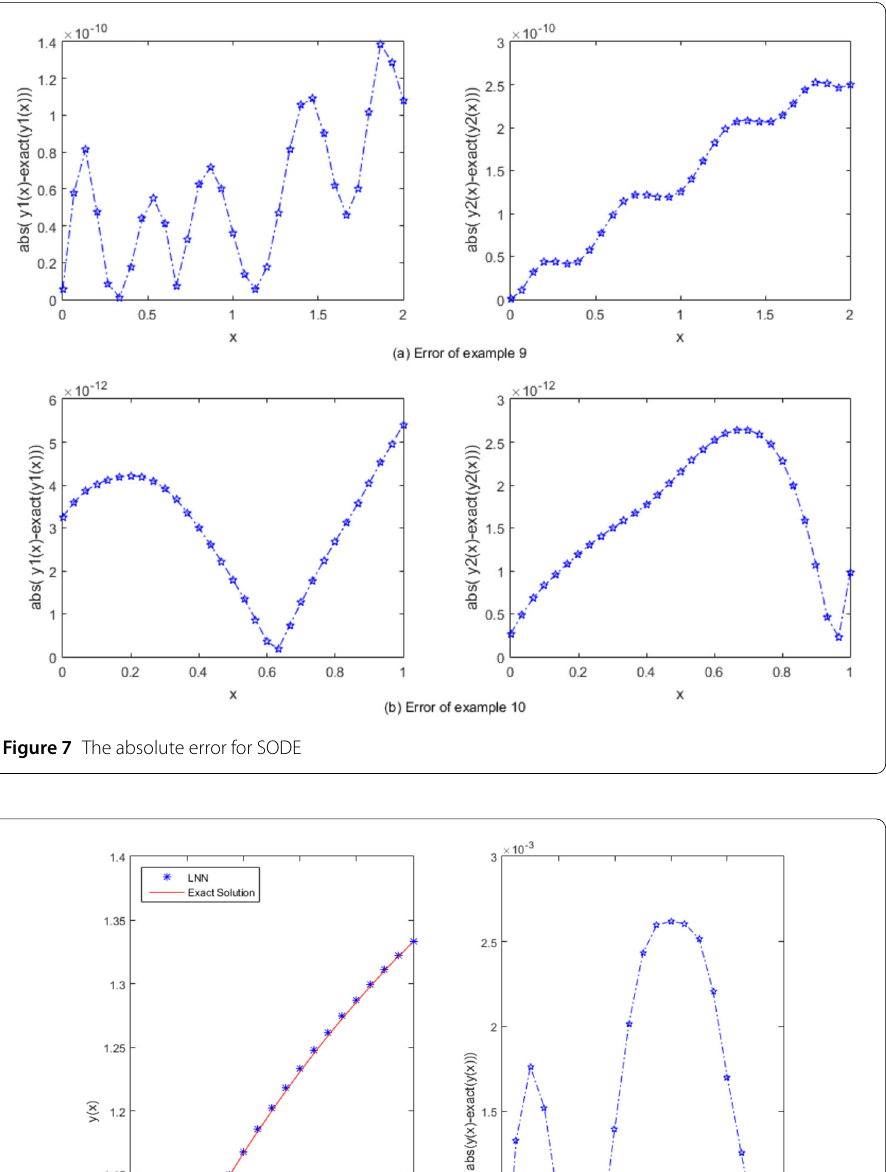
Figure 8 ( a ) Comparison between exact and LNN results; ( b ) Absolute errors of Example 11